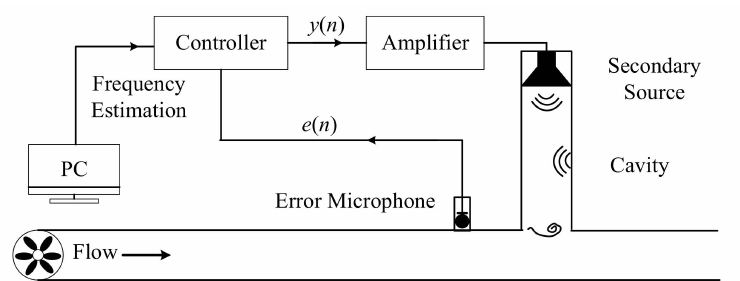
Figure 1. Schematic diagram of the ANC system for acoustic resonance noise.